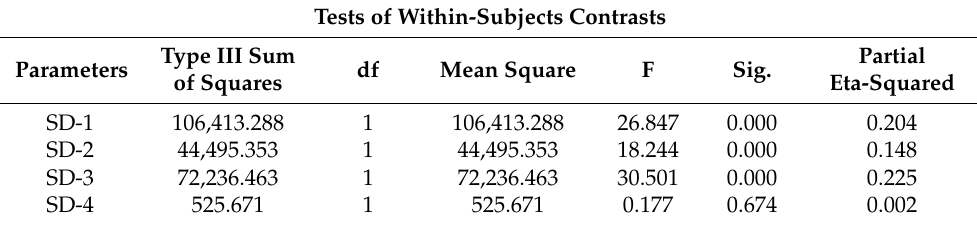
Table 6. Comparison of the reaction time for words and target stimuli. Tests of Within-Subjects